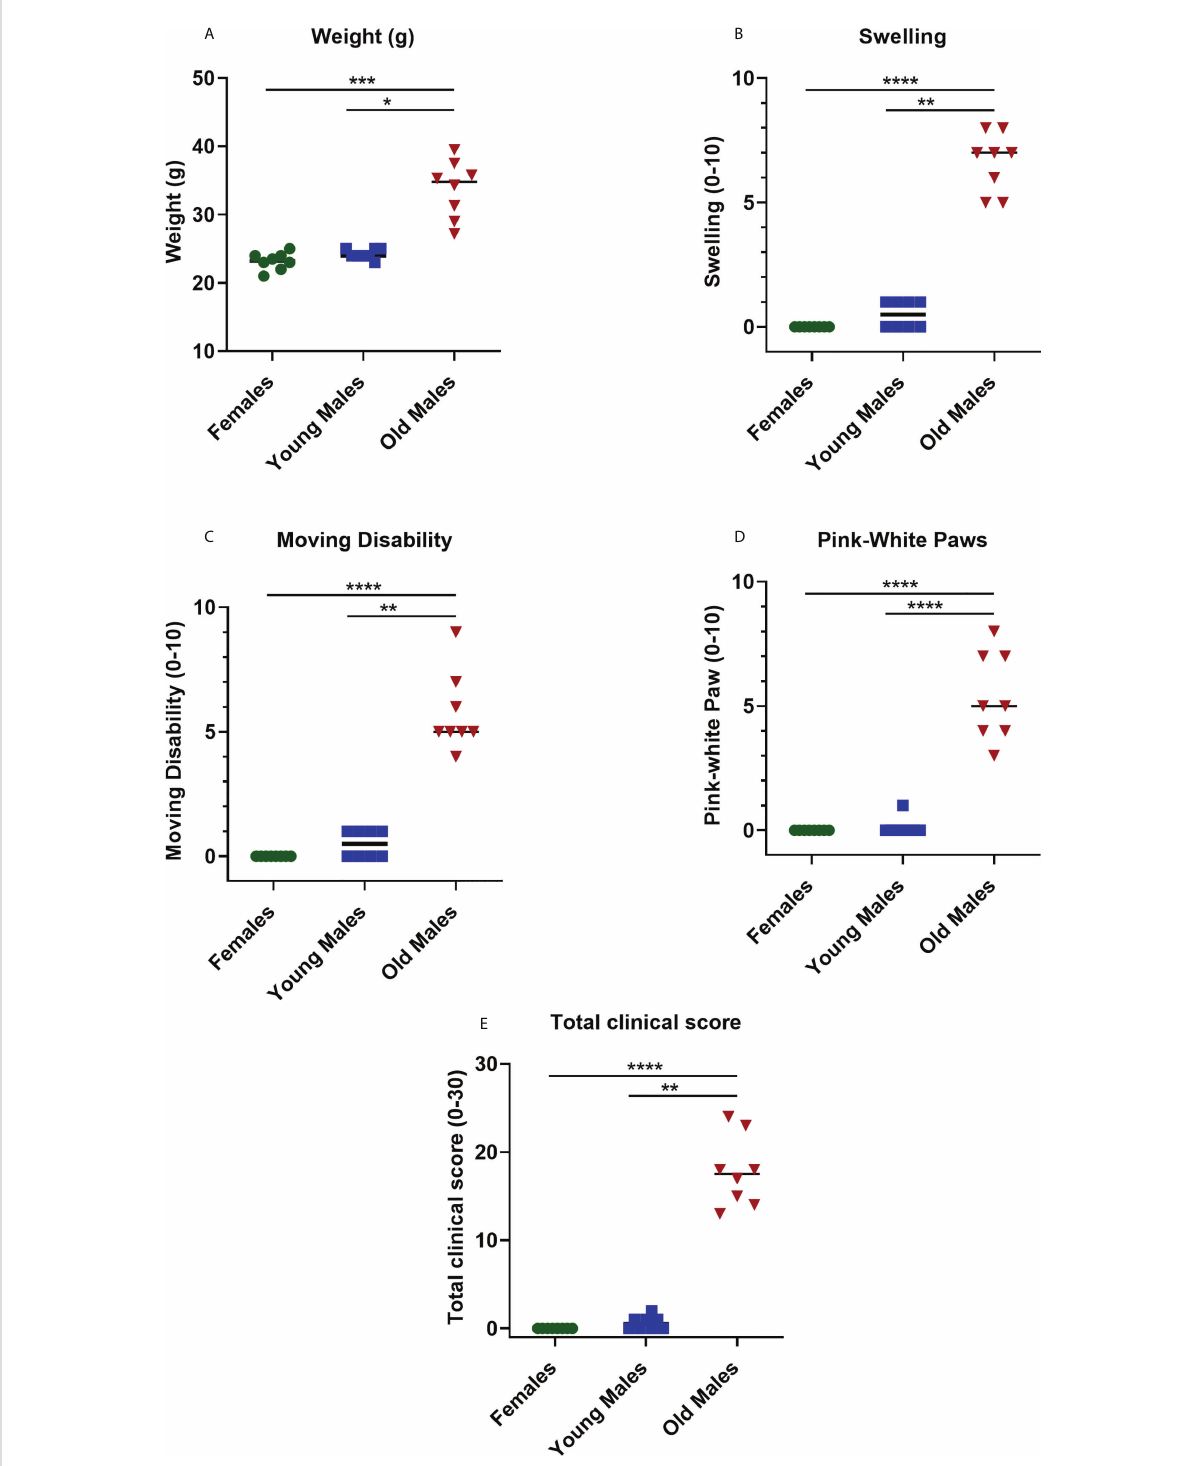
FIGURE 2 Changes in the physical status of the NZW/LacJ x BXSB/MpJ 9 F1 lupus mice. Body weight (A) , swelling/edema (B) , moving disability (C) , paleness of paws (D) and total clinical score (E) were measured in females (green circle dots), young/healthy males (blue square) and old sick males (red tringle). Data are presented as scatter dot plot with median line; n= 8 per group. P < 0.05 were regarded as statistically signi fi cant. Signi fi cant level (*p < 0.05; **p < 0.01; ***p <0.001, ****p < 0.0001) in comparison to